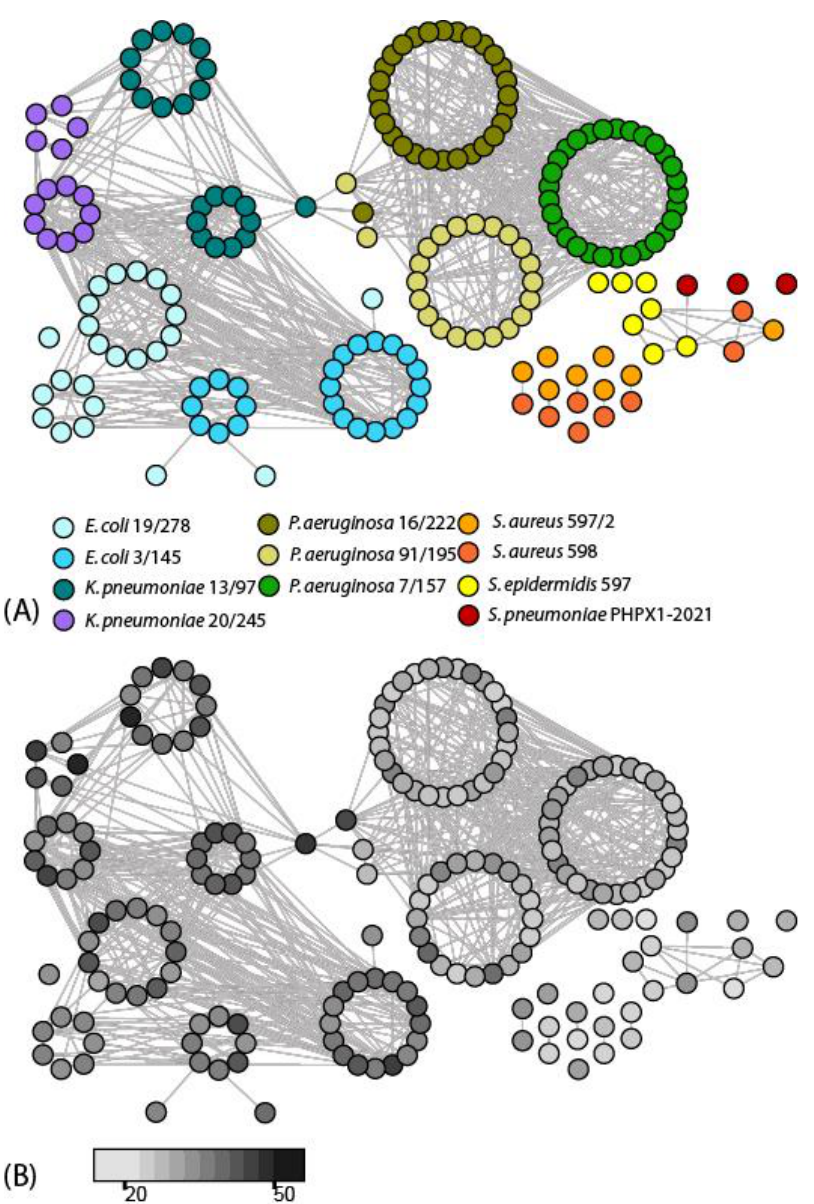
Figure 2. ( A ) Clustering of GIs identified in different genomes of pathogenic isolates through similarities in their patterns of tetranucleotides. Each node on the scheme corresponds to one GI. Numbers in several nodes are the consecutive clockwise numbers of GIs identified in the genomes, starting from the replication origins. Host microorganisms are depicted using different colors, as explained in the legend. ( B ) The network of GIs is identical to that in part A, but recolored in a way that the darker grey color represents more recent inserts of GIs, i.e., the GIs with more dissimilar patterns of tetranucleotides compared to the patterns calculated for the host microorganisms. The gradient bar below the scheme shows the correspondence of the grey shading to the distance between patterns calculated with the SeqWord Sniffer